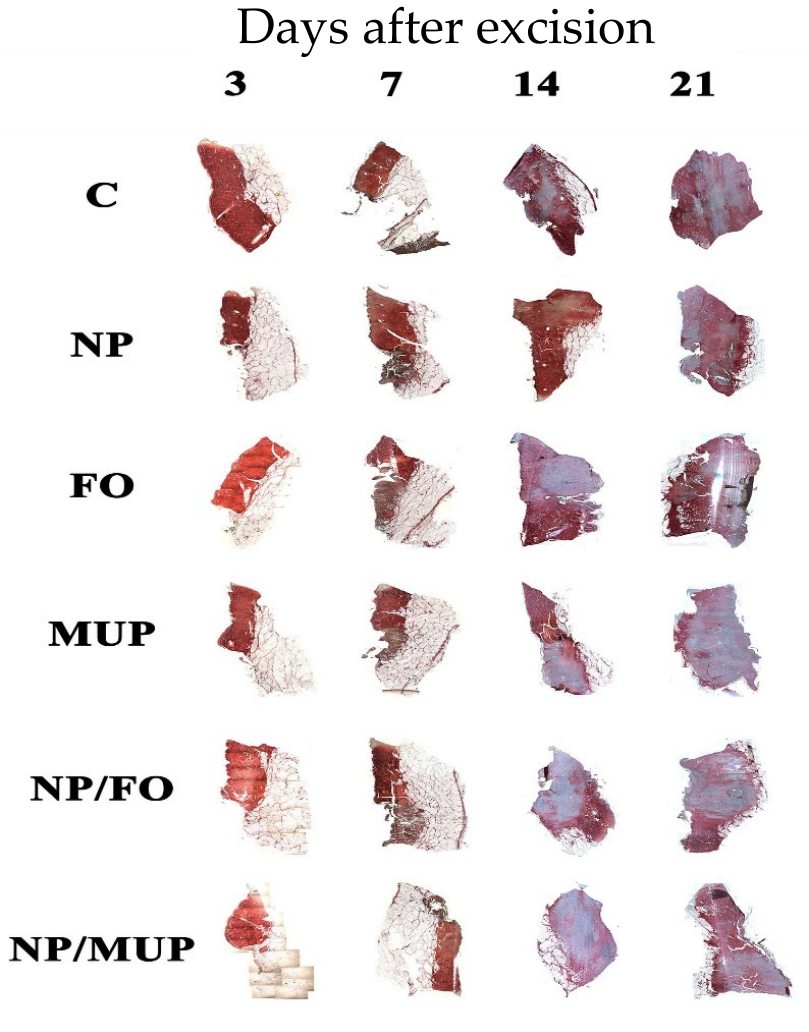
Figure 1. Collagenous tissue maturation (representative pig) semi-quantified using Sirius red staining. C—control (dressing alone); NP—dressing with empty PLGA-PVA nanoparticles (NPs); FO—dressing with fish oil; MUP—dressing with mupirocin; NP/FO—dressing with PLGA-PVA NPs with entrapped fish oil; NP/MUP—dressing with PLGA-PVA NPs with entrapped mupirocin. Histological images are magnified 10×.